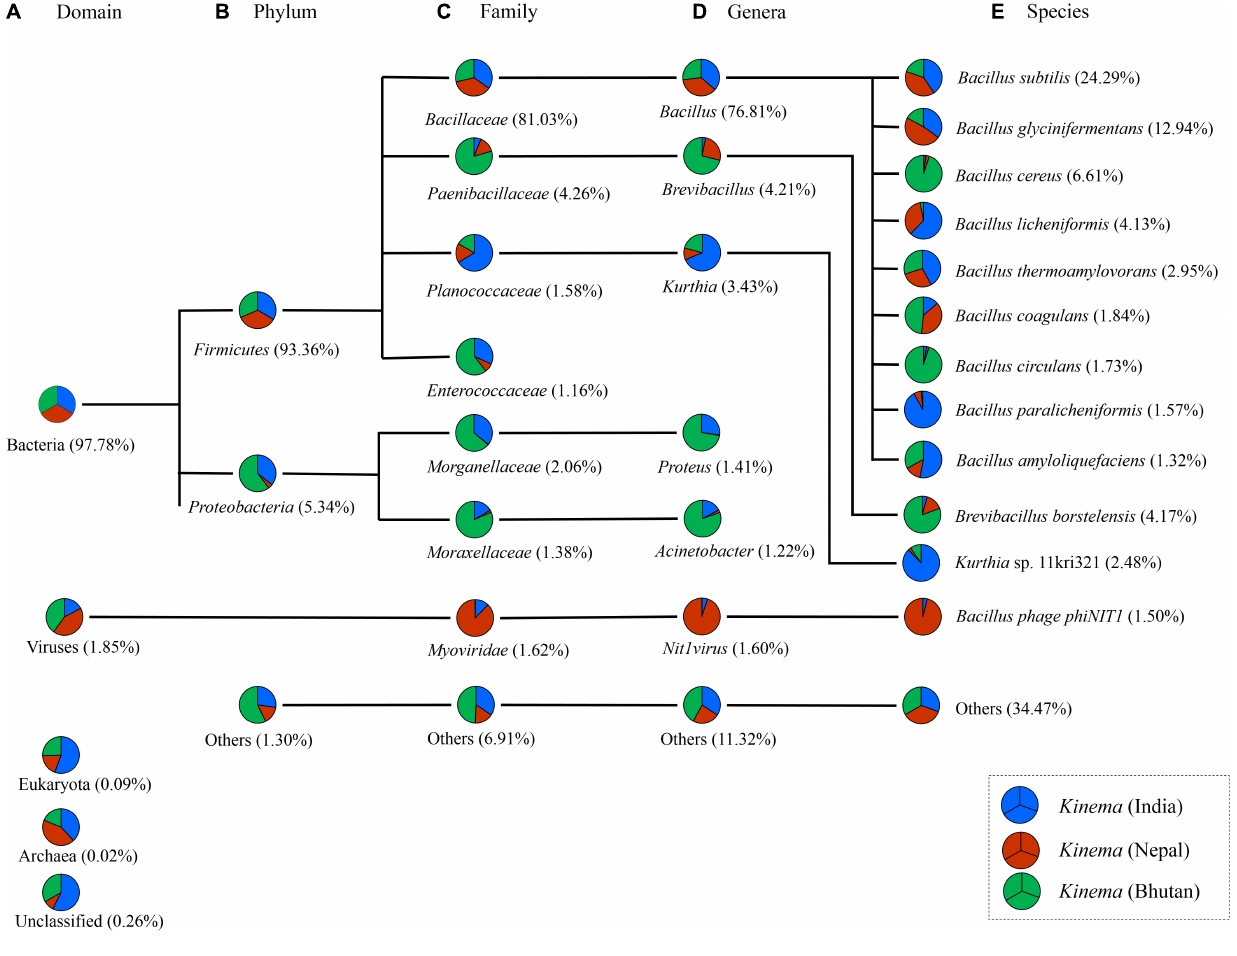
Frontiers in Microbiology |